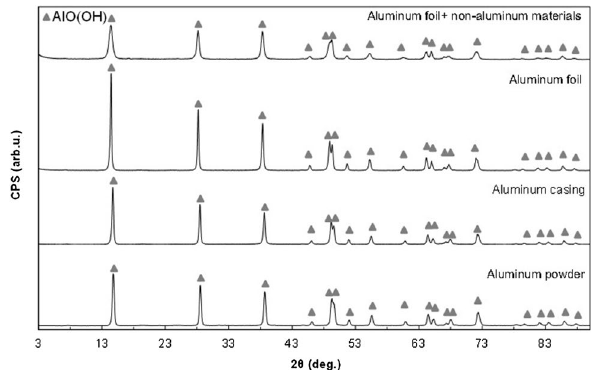
Fig. 6 XRD profiles for solid products from reactions using